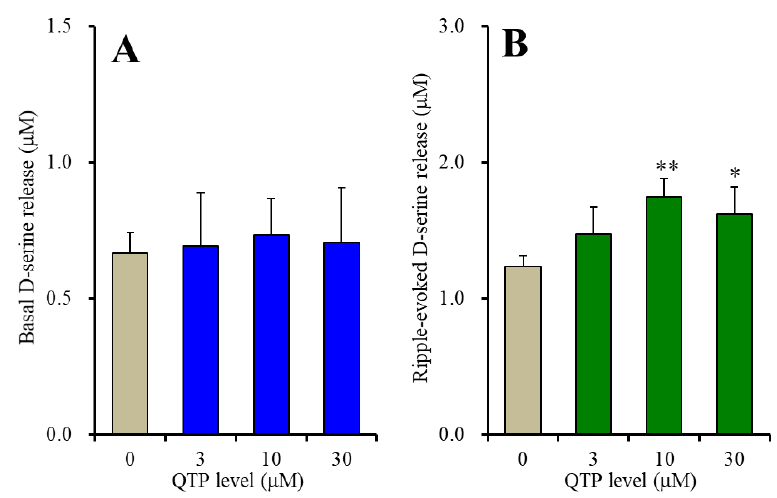
Figure 2. Concentration-dependent effects of subchronic administration of quetiapine (QTP) on basal ( A ) and artificial ripple-burst evoked ( B ) astroglial D-serine releases. Ordinate indicates the mean ± SD of extracellular D- serine level (μM) ( n = 6 ). Abscissa indicates QTP concentration (μM). * p <